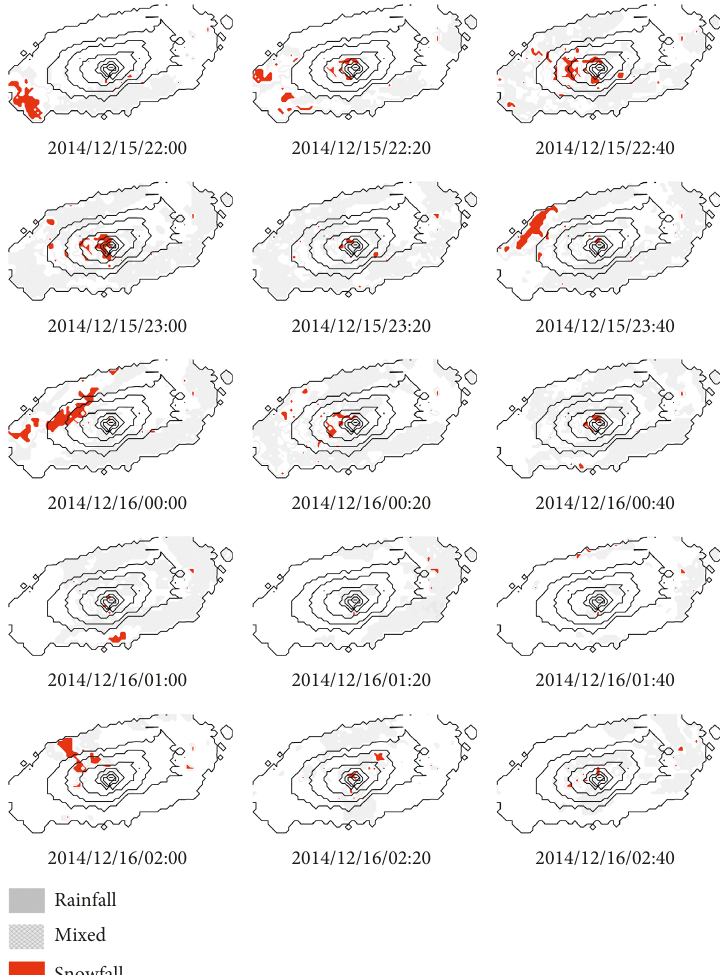
Figure 10: Mapping result of the snowy region by applying the variable threshold method (from 22:00 December 15 to 02:40 December 16,